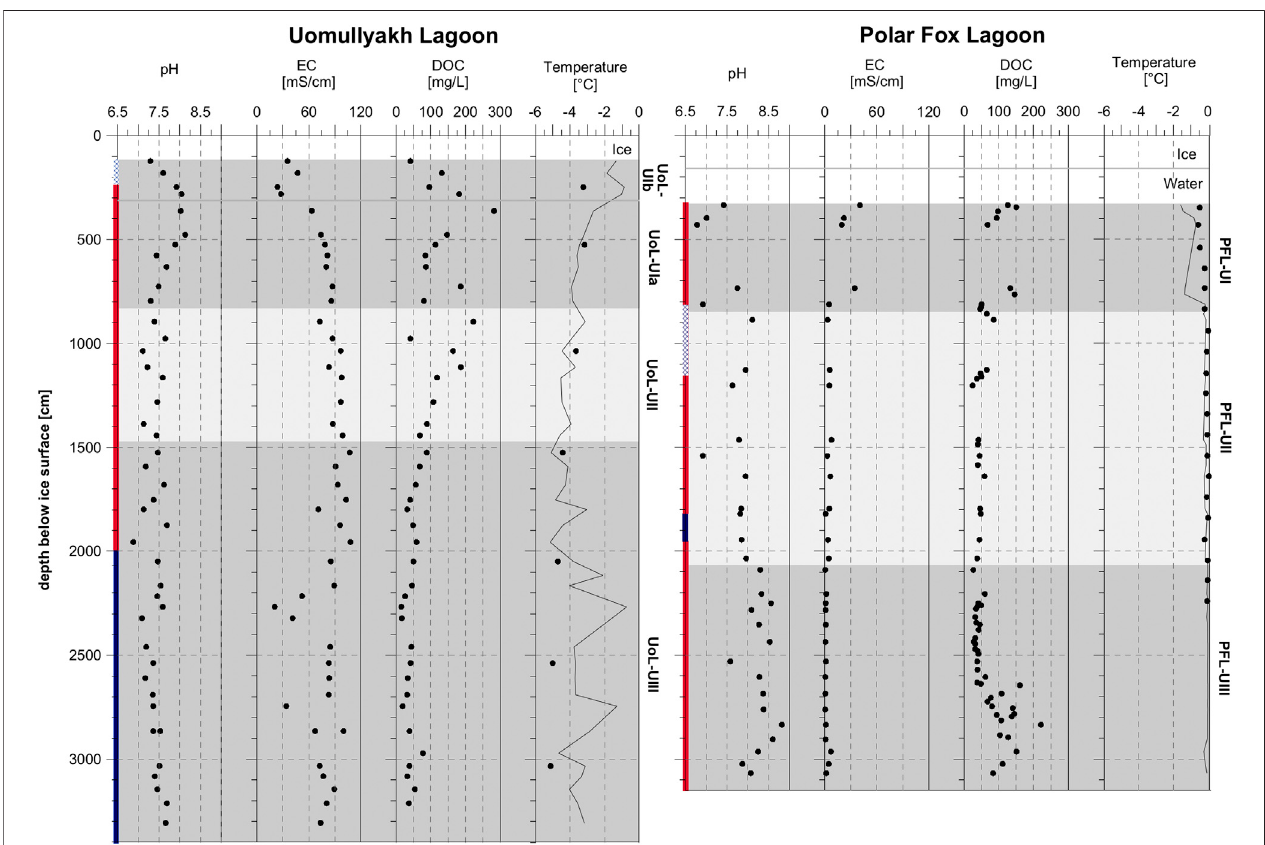
FIGURE 4 | Hydrochemical parameters of the pore water and borehole temperature of the Uomullyakh Lagoon (left) and the Polar Fox Lagoon cores (right) : pH, electrical conductivity (EC), dissolved organic carbon concentration (DOC), measured borehole temperature (point) and freezing point (line) estimated from pore water salinity. Color bar at the y -axis indicates frozen (blue), unfrozen (red) and partially frozen (shaded) core segments. Note that at UoL “ frozen ” includes visibly frozen core sections and re-constructed frozen conditions.